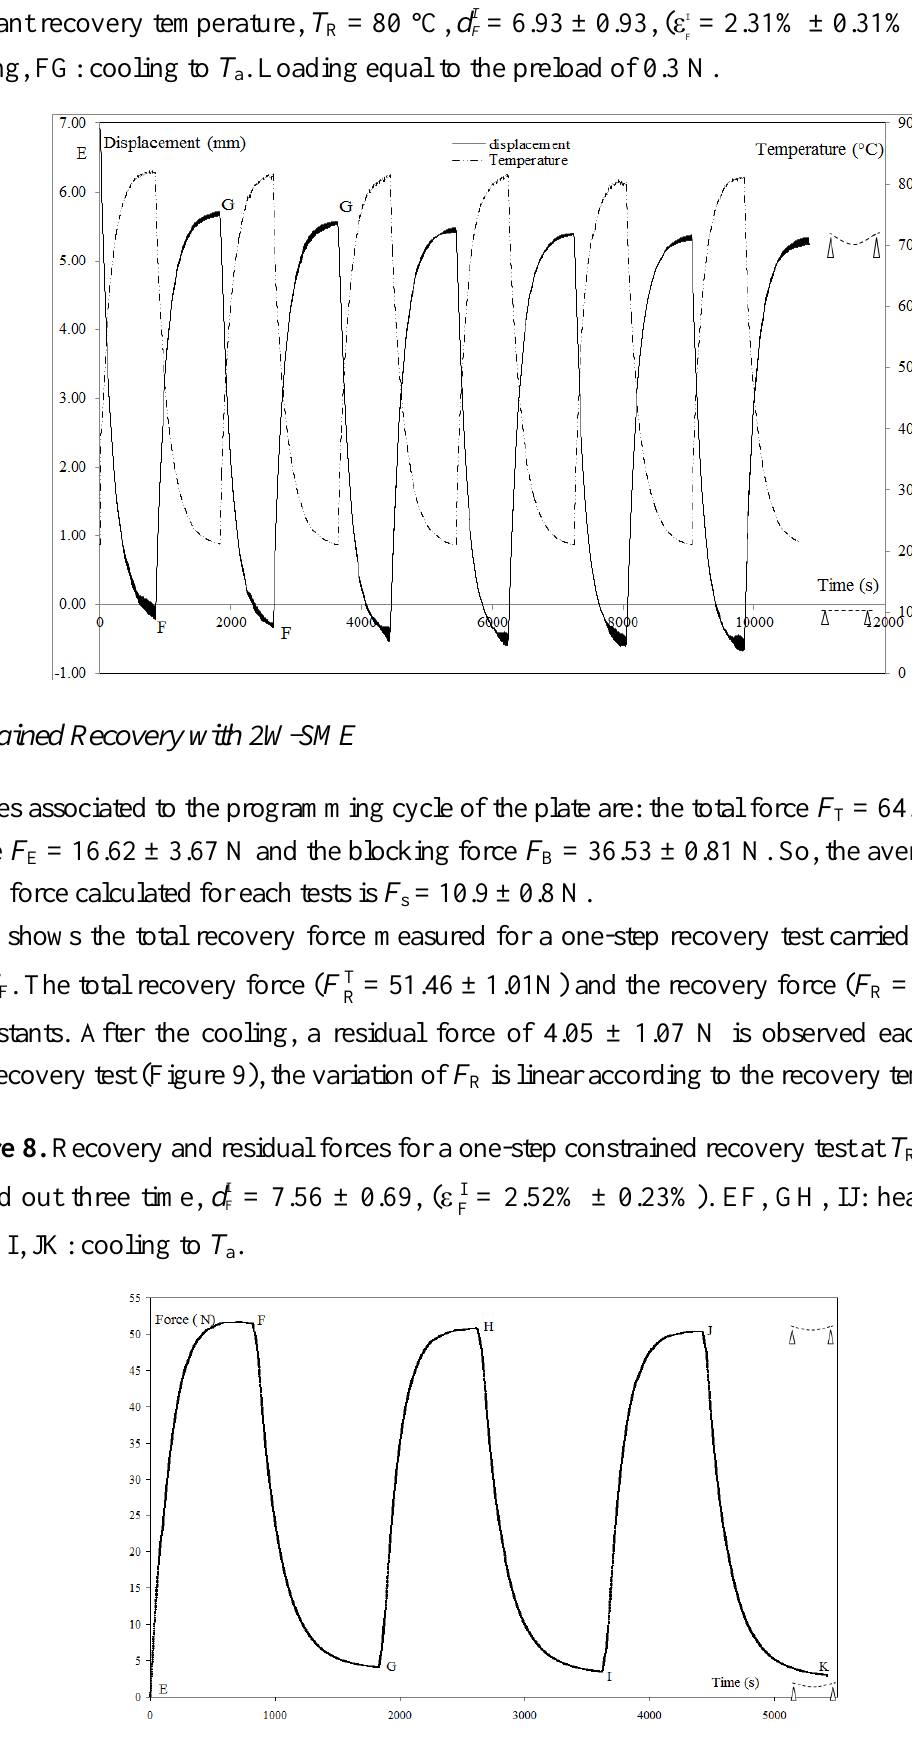
Figure 7. Recovery displacement for an unconstrained multi-step recovery cycle with a constant recovery temperature, T heating, FG: cooling to T